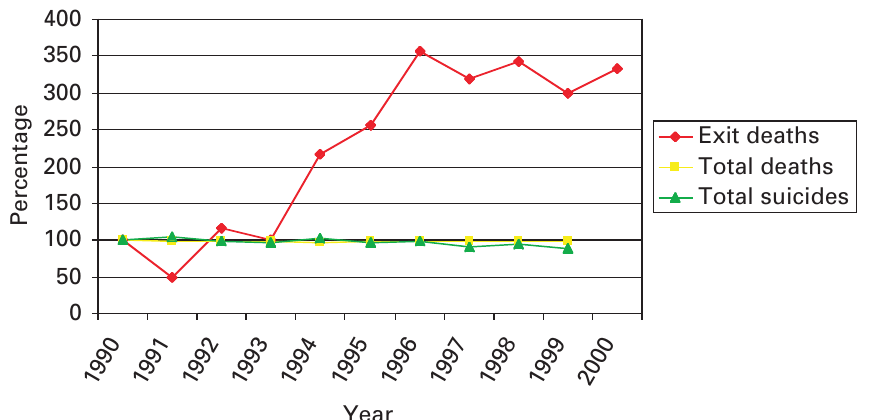
Exit deaths, total deaths and total